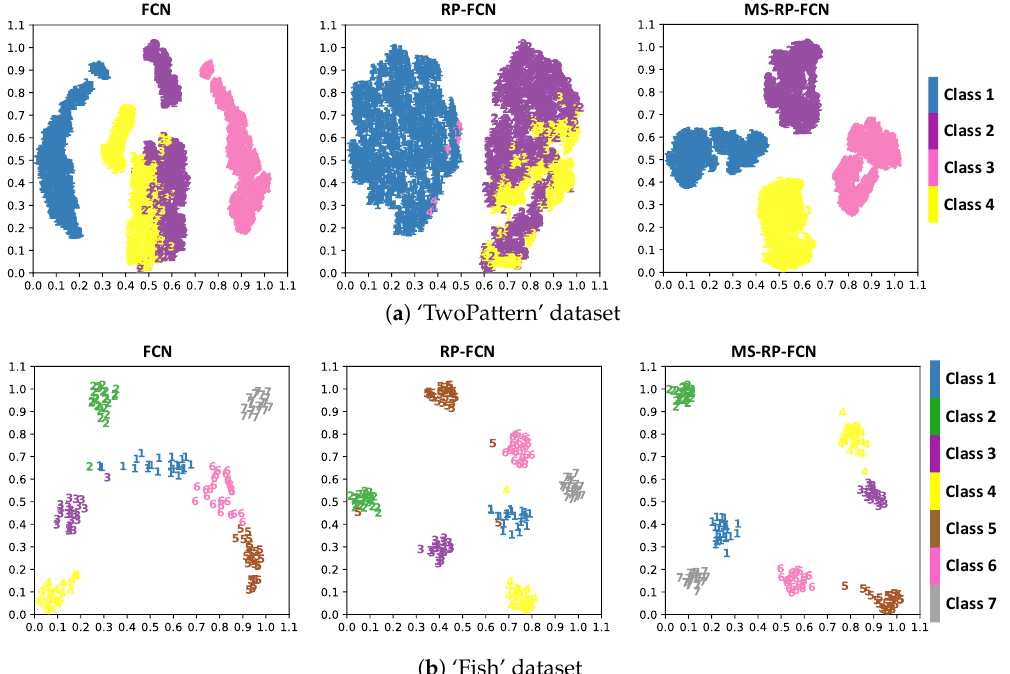
Figure 10. Visualizations of different input data by t-SNE. (left column: features learned from the raw data; middle column: features learned from the RP image data; right column: features learned from MS-RP image